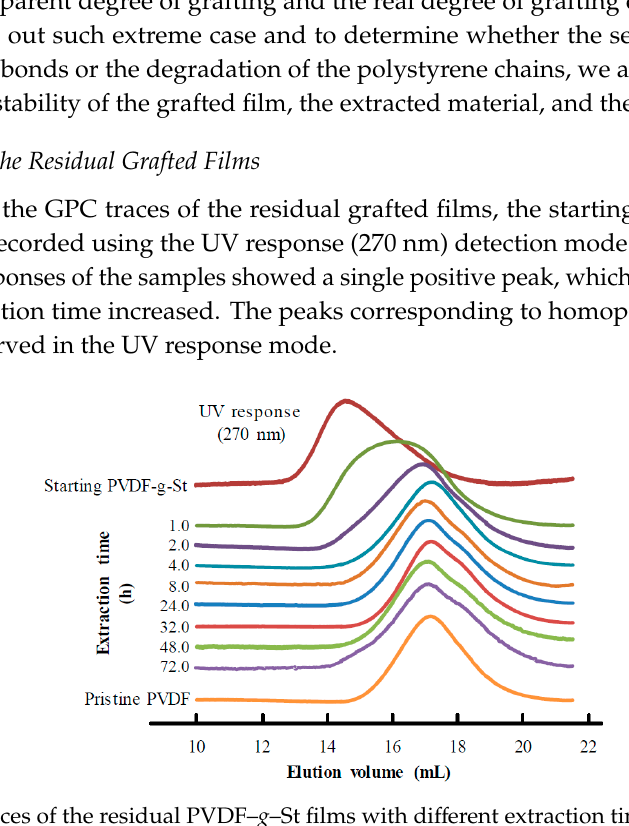
Figure 5. GPC traces of the residual PVDF– g –St films with different extraction times, corresponding starting PVDF– g –St film, and pristine PVDF film. Eluent, 10 mM LiBr in DMF; flow rate, 1.0 mL / min; column temperature, 40 ° C; UV detector, 270 nm.